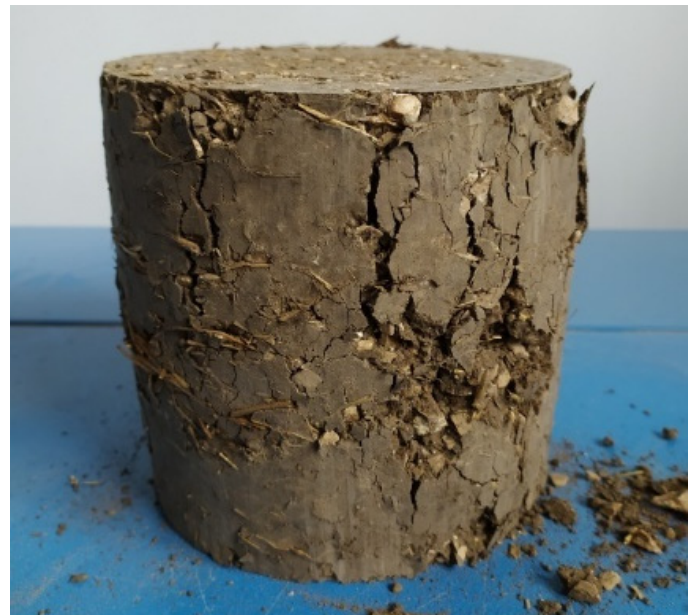
Figure 7. Failure of the specimens of compression test.